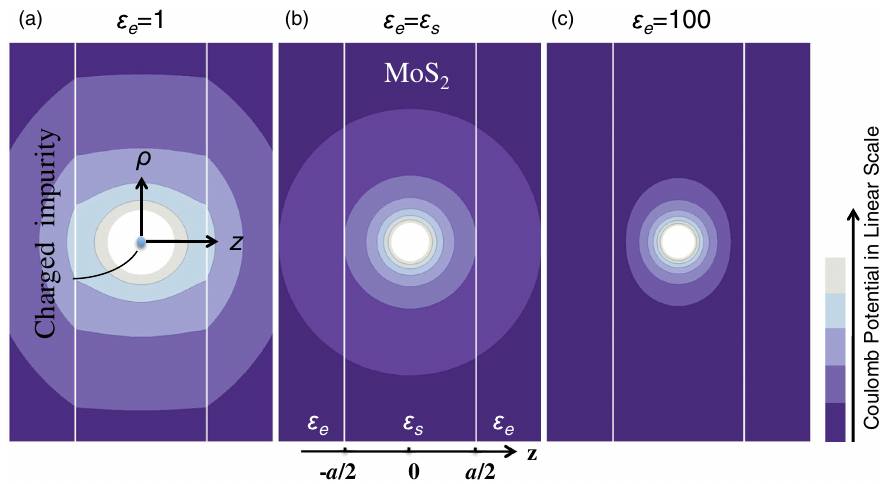
FIG. 1. Coulomb potential contours due to an on-center point charge for three different dielectric environments: ε